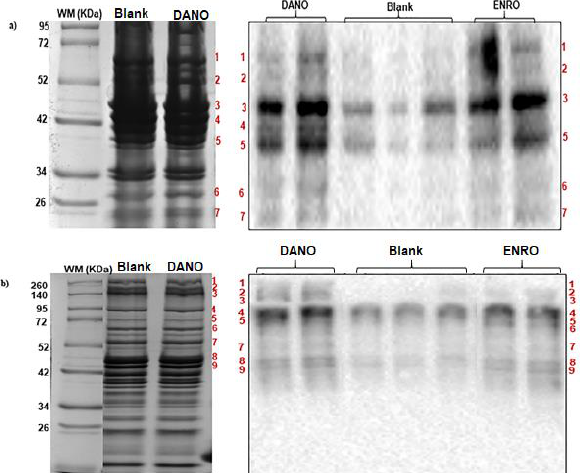
Figure 5. Carbonylation patterns (Western blot) and sodium dodecyl sulfate–polyacrylamide gel electrophoresis (SDS-PAGE) of beef proteins. 1D oxyblots (right) from ( a ) sarcoplasmic and ( b ) myofibrillar proteins were matched against SDS-PAGE (left) to identify carbonylated protein bands from blank and treated samples with danofloxacin and enrofloxacin at MRL contamination level (200 and 100 µg·Kg −1 , respectively). Matched bands were excised from SDS-PAGE, digested and analyzed by mass spectrometry. Due protein profiles resulted similar in all cases by each protein fraction, only two lanes, with blank and DANO treated samples, are showed in the SDS-PAGE. In Western blot, treated and blank samples were loaded by duplicate and triplicate, respectively.